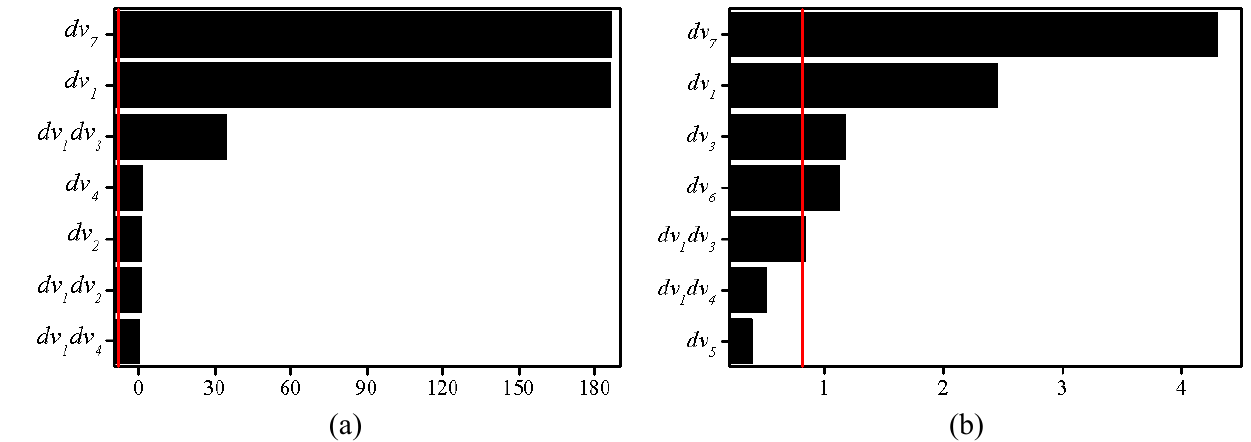
Figure 10. Pareto chart of the standardized effects (alpha=0.05) (a) Normal force response (b) Total weight